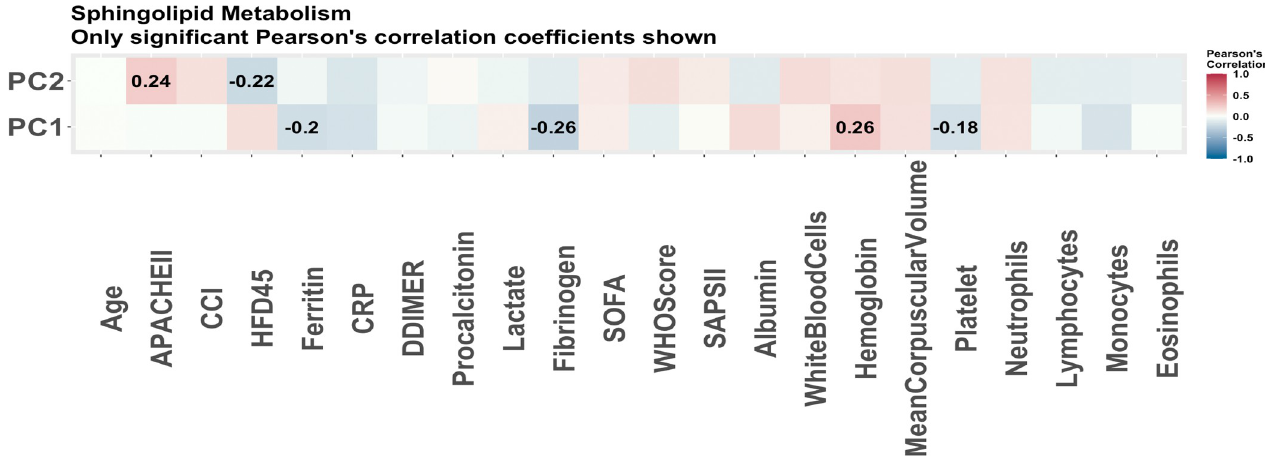
Fig 6. The Pearson correlations of principal components of pathways associated with disease severity (all patients). The Pearson correlations of clinical covariates and the principal components used to summarize the enriched pathways with disease severity as predicted by IPA. These are the pathways predicted to be enriched based on the 67 proteins determined to be associated with disease severity via stability selection. Only the correlations which were significant (p- value < 0.05) are reported. These pathways all have multiple significant correlations with clinical covariates.